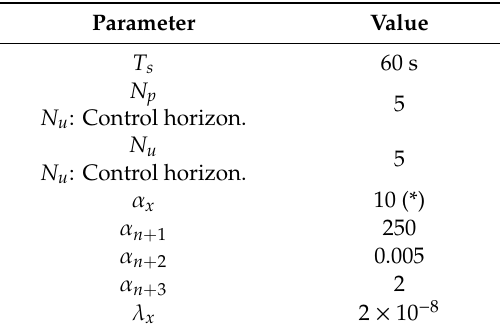
Table 3. Controller